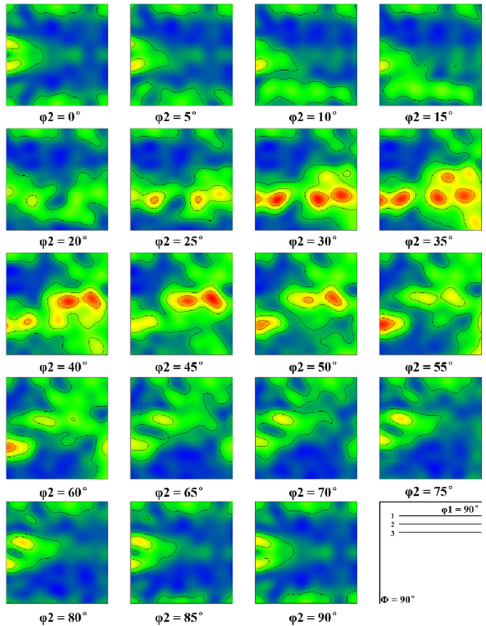
Figure 16. ODF diagram of a copper ultrasonic welding joint.